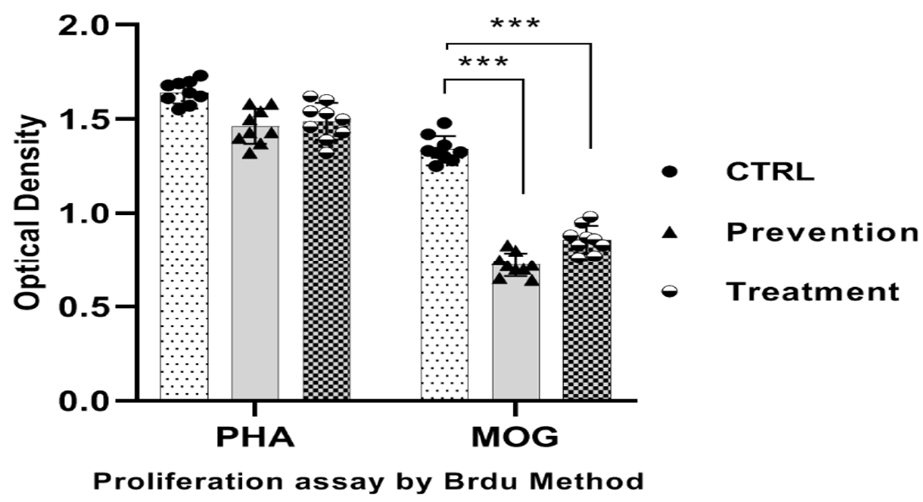
Figure 3. Oral administration of MOG suppresses T-cell proliferation. Splenocytes and lymph nodes were harvested on day 25 post-immunization and cultured in PHA (20 µ g/mL), as a positive control, or with MOG (20 µ g/mL) for 72 h on 96-well plates. Proliferation responses were tested using a Cell Proliferation ELISA, BrdU (colorimetric) kit (Roche Applied Science, Indianapolis, USA). The proliferation assay was conducted in triplicates. Data presented as mean optical density ± SEM. *** p < 0.001, when compared with control group. Mice were divided into three groups: 1. Control group (CTRL, n = 9); 2. Prevention group with MOG (n = 9); 3. Treatment group with MOG (n = 9).